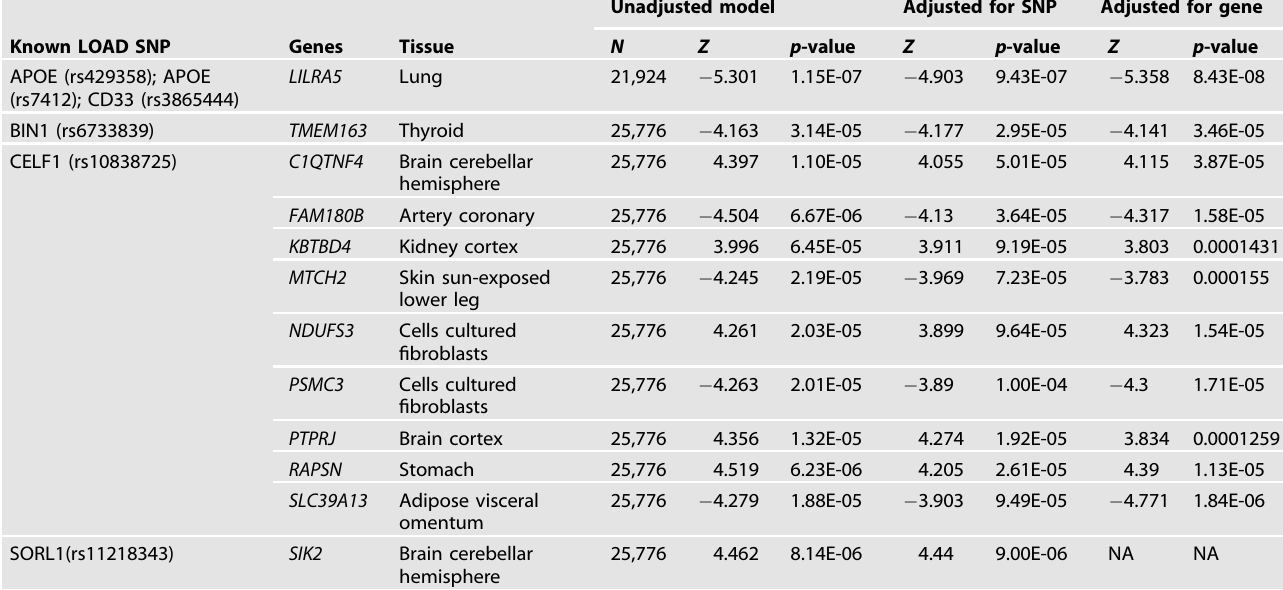
Table 2. The genes with signi fi cant effect independent to nearby known LOAD SNPs. Unadjusted model Adjusted for SNP Adjusted for